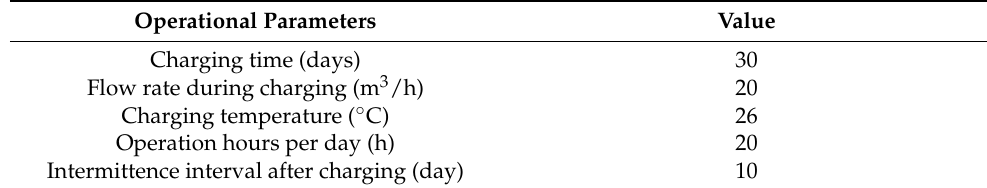
Table 3. Operating condition of the deep BTES system during the low temperature heat storage. Operational